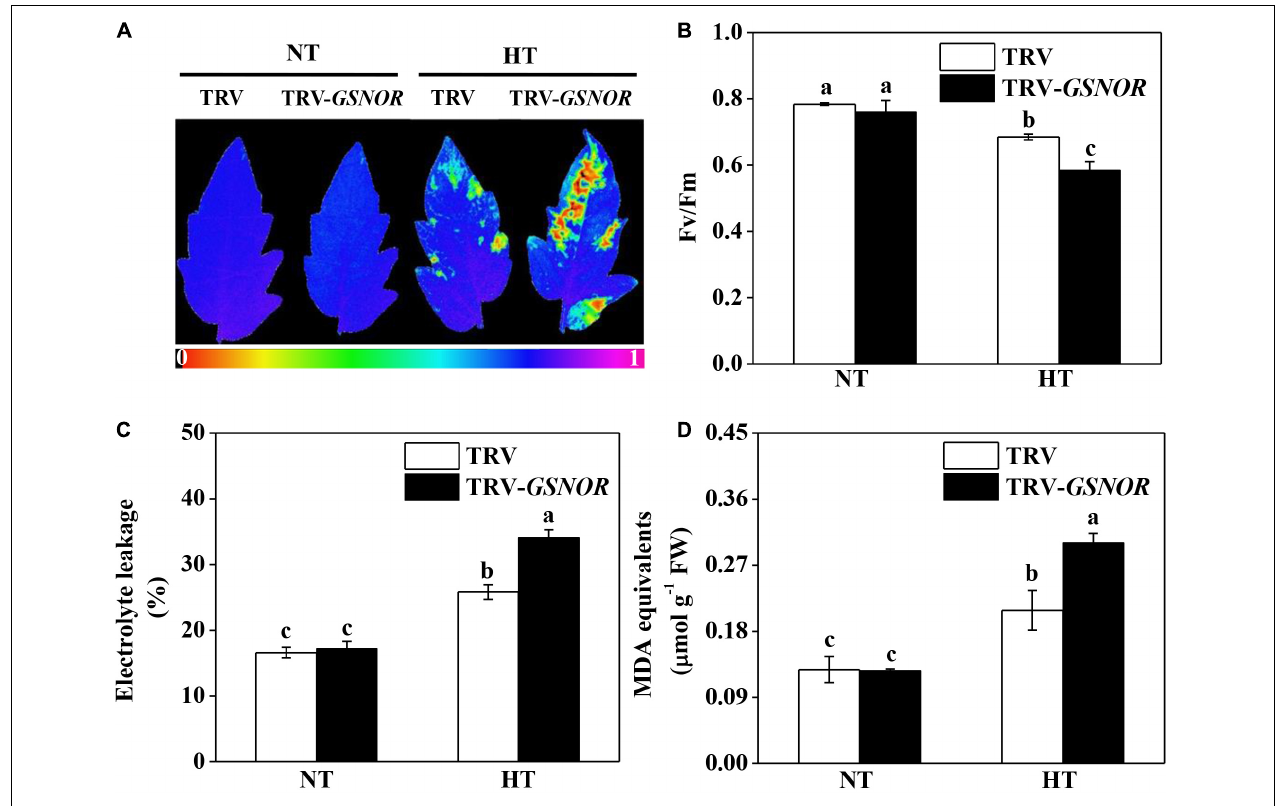
FIGURE 2 | Silencing of SlGSNOR1 compromised thermotolerance. (A) Images of maximum quantum yield (Fv/Fm) of leaves after 24 h exposure to high temperature (42 ◦ C/38 ◦ C) or normal temperature (21 ◦ C/16 ◦ C). The pseudocolor scale at the bottom of the image ranges from 0 (black) to 1 (purple). (B–D) Fv/Fm values, electrolyte leakage and malondialdehyde (MDA) content in leaves after 24 h exposure to high temperature. Data are means of five replicates ( ± SD). Means denoted by the same letter did not significantly differ at P < 0.05, according to Tukey’s test. NT, normal temperature; HT, high temperature.